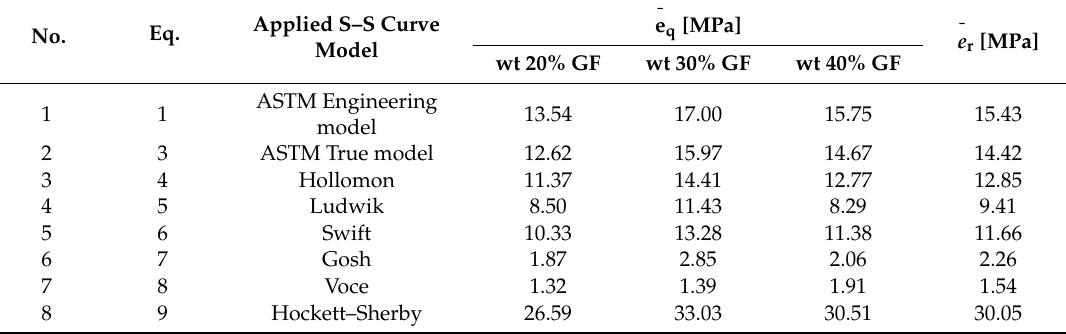
Figure 8. Di ff erences between inverse models and experimental results: ( a ) inverse models of GFRP wt 20% GF; ( b ) inverse models of GFRP wt 30% GF; ( c ) inverse models of GFRP wt 40% GF. Table 2. Errors between experimental results and FEA results.